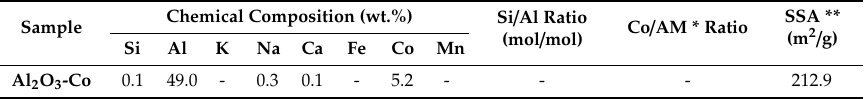
Table A1. Chemical composition and specific surface area of